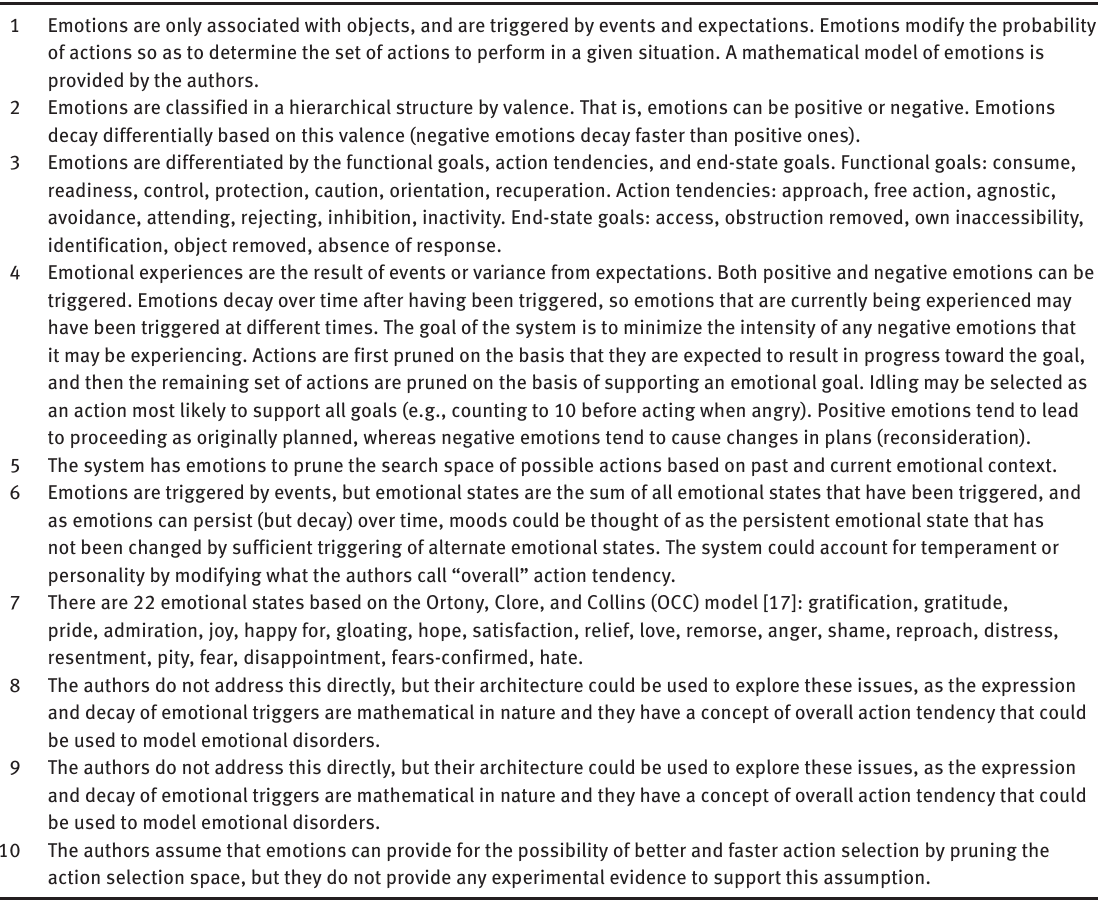
Table 11. Mathematical Classification of Action Tendency